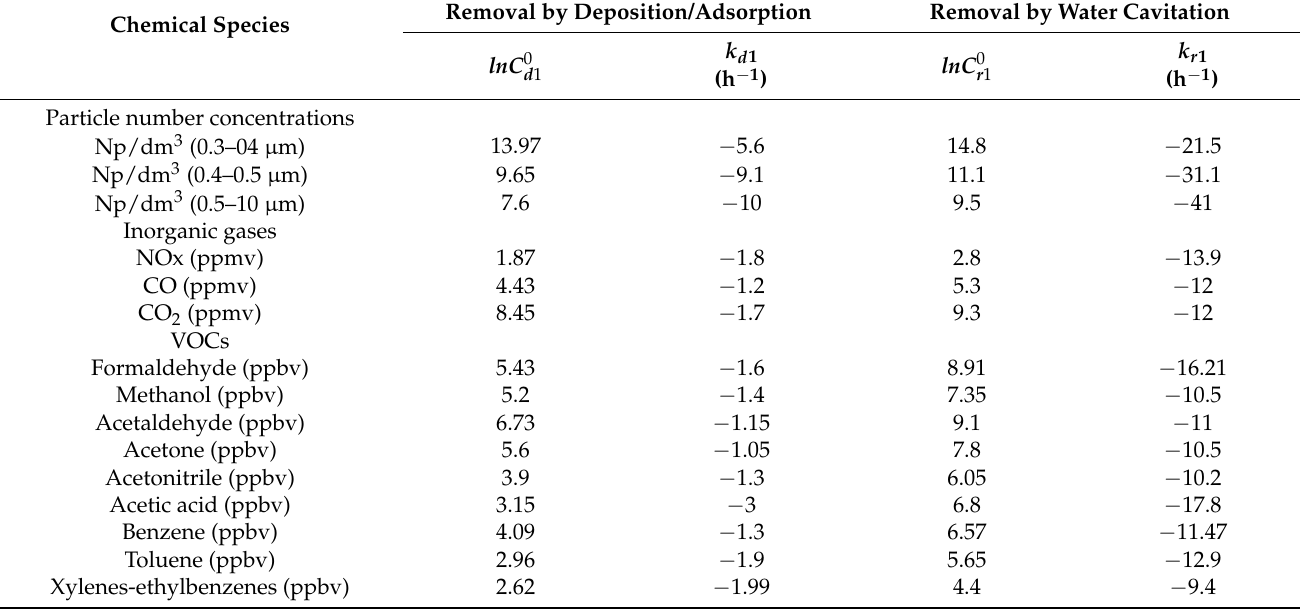
Table 2. Values of the intercepts and slopes of the regression lines determined for different pollutants emitted from diesel exhaust emission. Data refer to the experiments reported Figures 2–4, using the GIOEL air cleaner run at the minimum flow. The subscript d refers to the decay of pollutants due to natural deposition/adsorption inside the room, whereas the subscript r refers to the removal by water cavitation. The values of lnC 0 and lnC 0 were calculated at the value of t = 0 in the graphs of r 1 d 1 Figures 2–4, indicated also in the text as t INIT